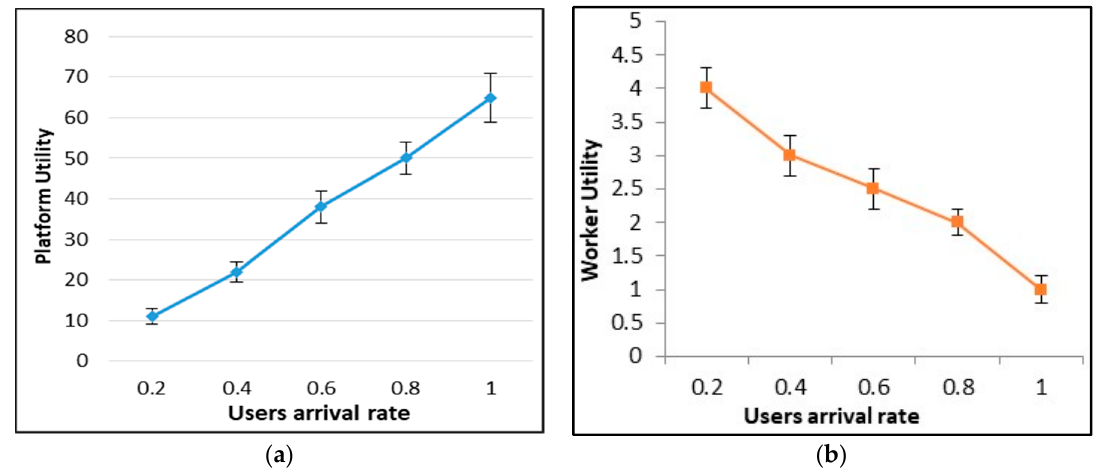
Figure 11. Users arrival rate for ( a ) platform utility and ( b ) worker’s utility.